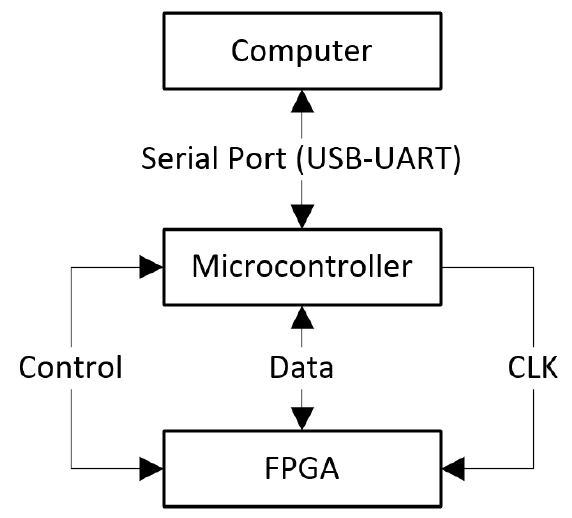
Figure 11. Test environment developed.